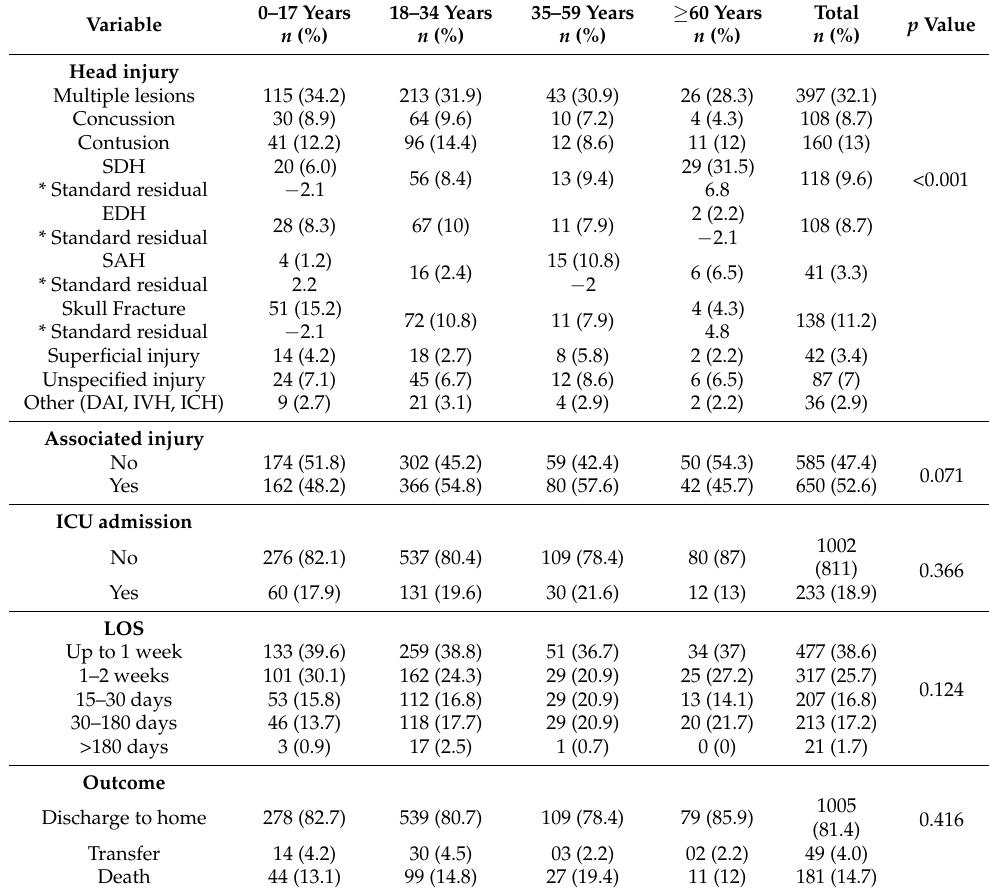
Table 4. Patterns of head injuries and its outcome by age ( n =